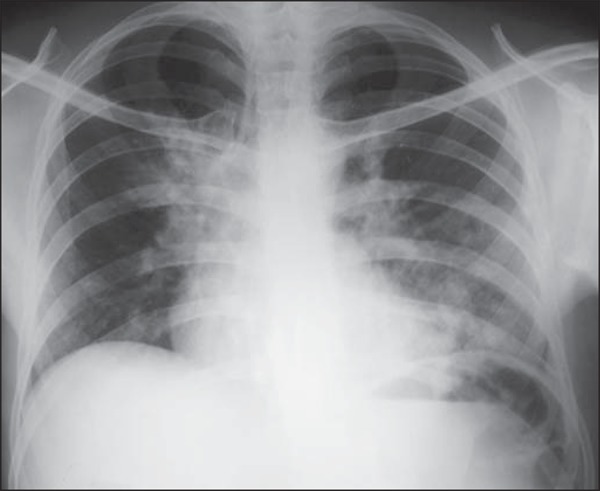
A 31-year-old man with heterogeneous and homogeneous, parahilar, bilateral
pulmonary consolidations.